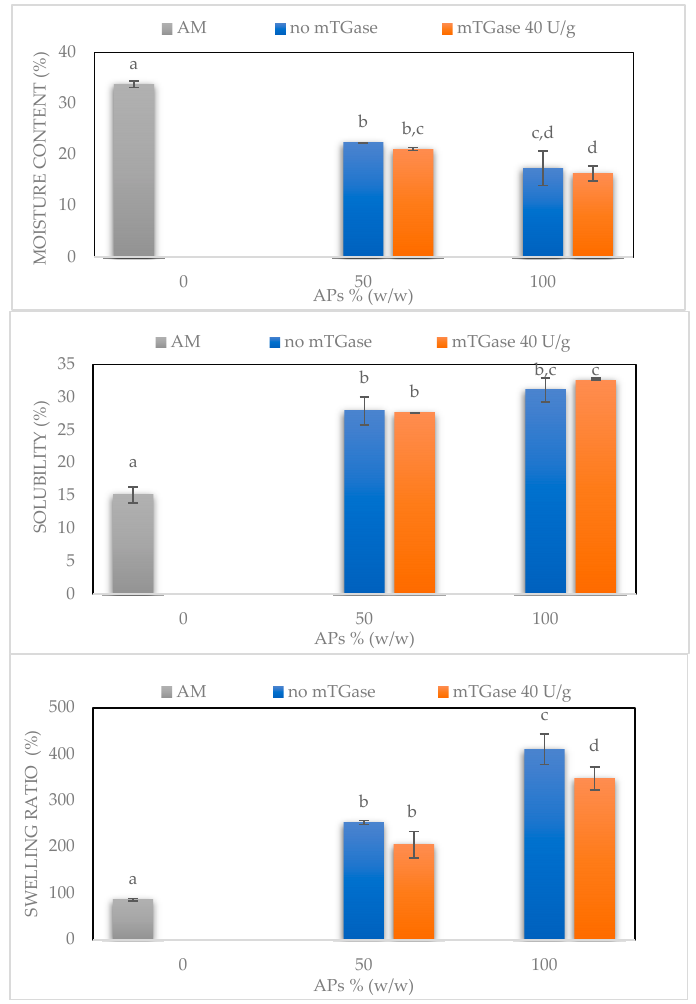
Figure 6. Moisture content, water solubility, and swelling ratio of AM100-based films, blended films (APs50-AM50) in the absence and the presence of mTGase, and APs100-based films treated or not by the enzyme. Different small letters (a–d) indicate significant differences among the values reported in each bar ( p < 0.05). The analysis was carried out in triplicate.